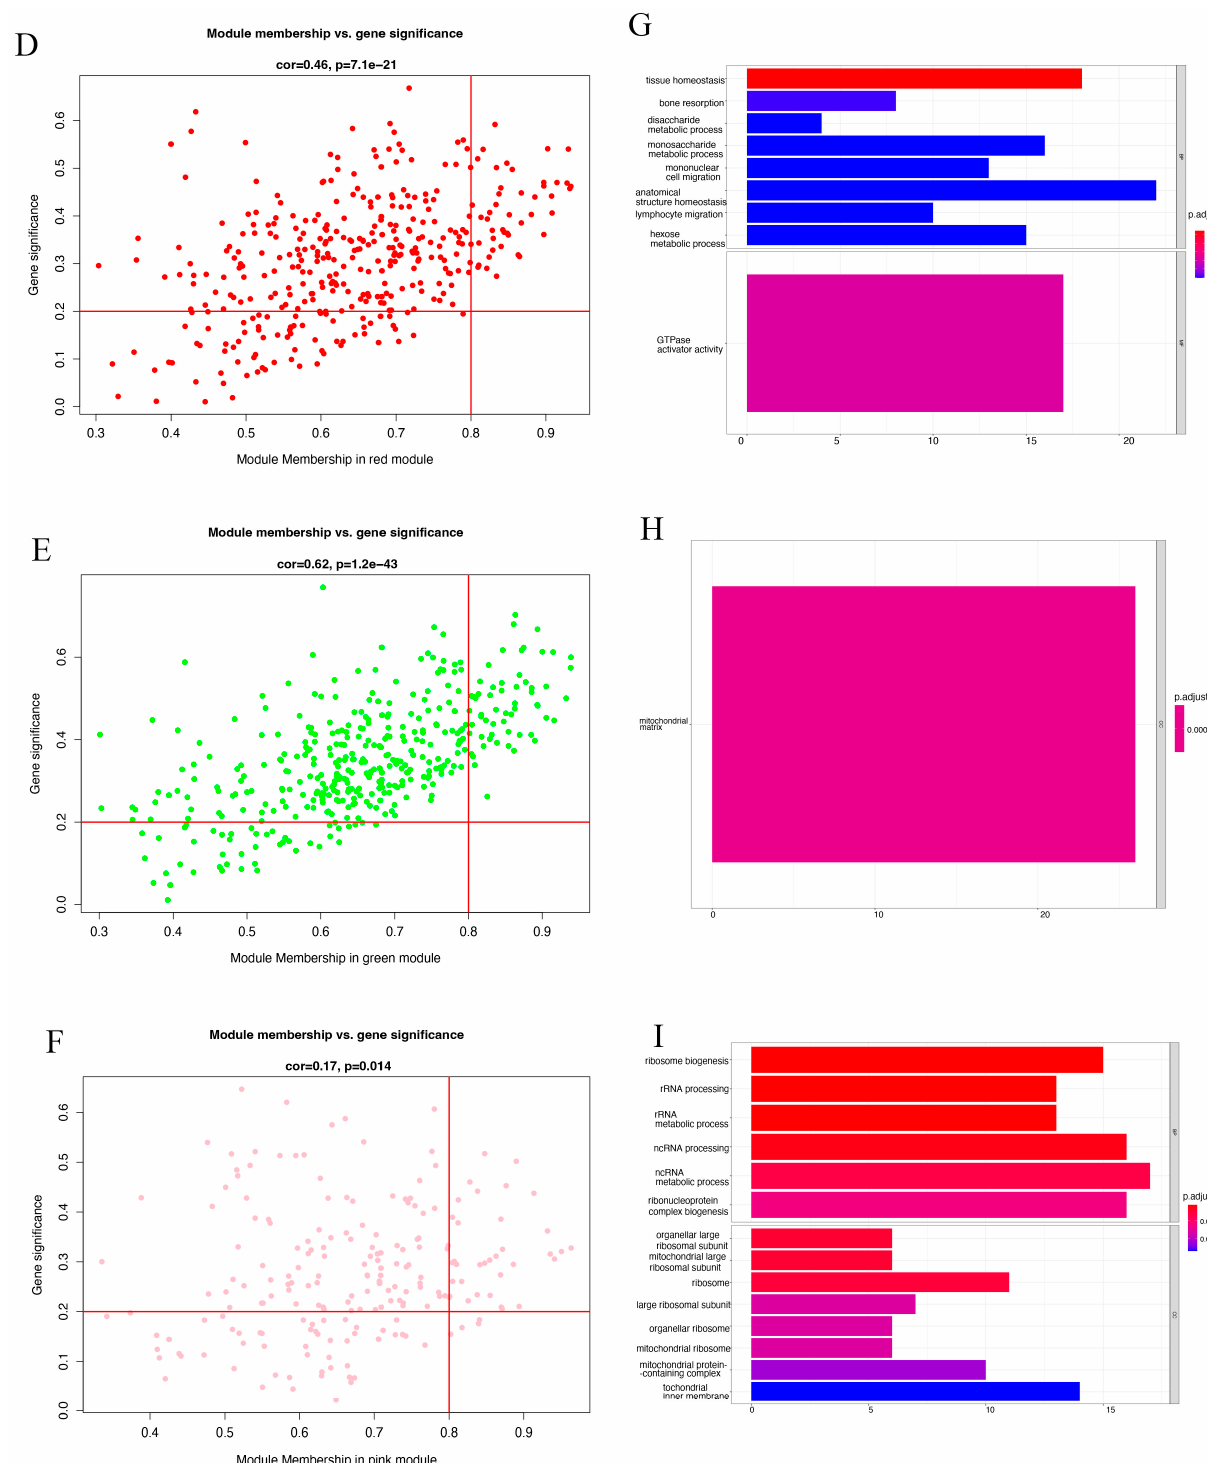
Figure 4. Identification of the hub modules and genes by WGCNA. ( A ) The soft-threshold power selecting processes included the scale-free fit index (left) and the mean connectivity (right) analysis. ( B ) Eigengene adjacency heatmap of correlation between the modules. ( C ) Heatmap of the correlation between module eigengenes and clinical traits of AAA. ( D–F ) Scatter plots of the correlation between MM and GS of red, green, and pink modules, respectively. ( G–I ) Bar charts of the GO analysis of genes from red, green, and pink modules, respectively.